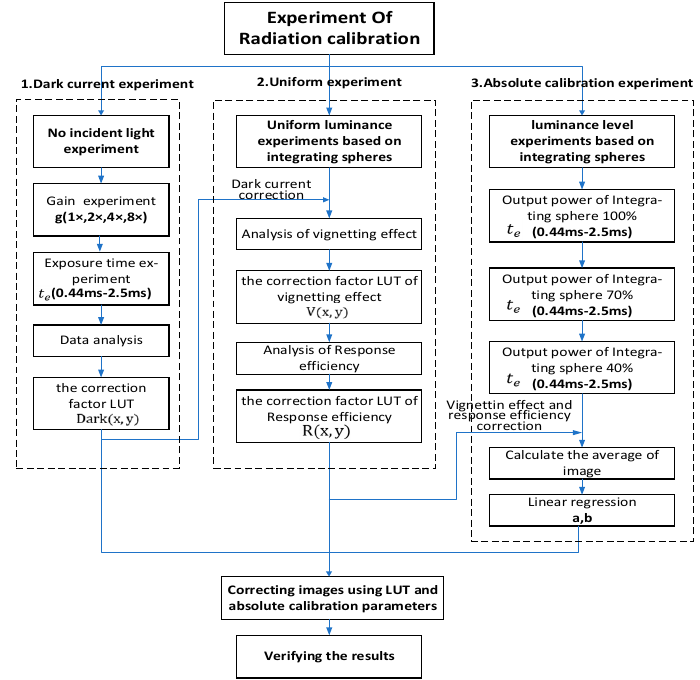
Figure 4. Workflow of radiation calibration experiment.